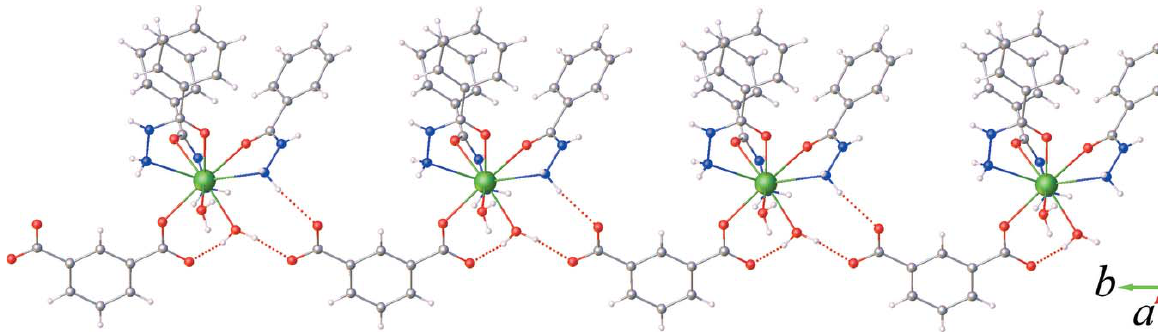
Figure 3 View of a supramolecular chain formed by O—H (cid:3)(cid:3)(cid:3) O and N—H (cid:3)(cid:3)(cid:3) O hydrogen bonds.